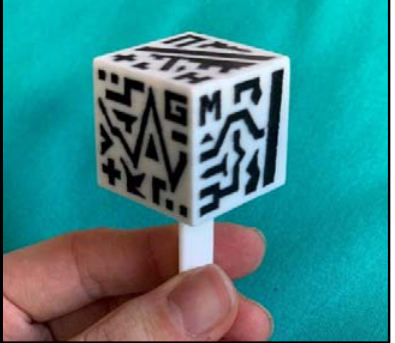
Figure 3. 3D-printed augmented reality cubic marker used in the augmented reality system.